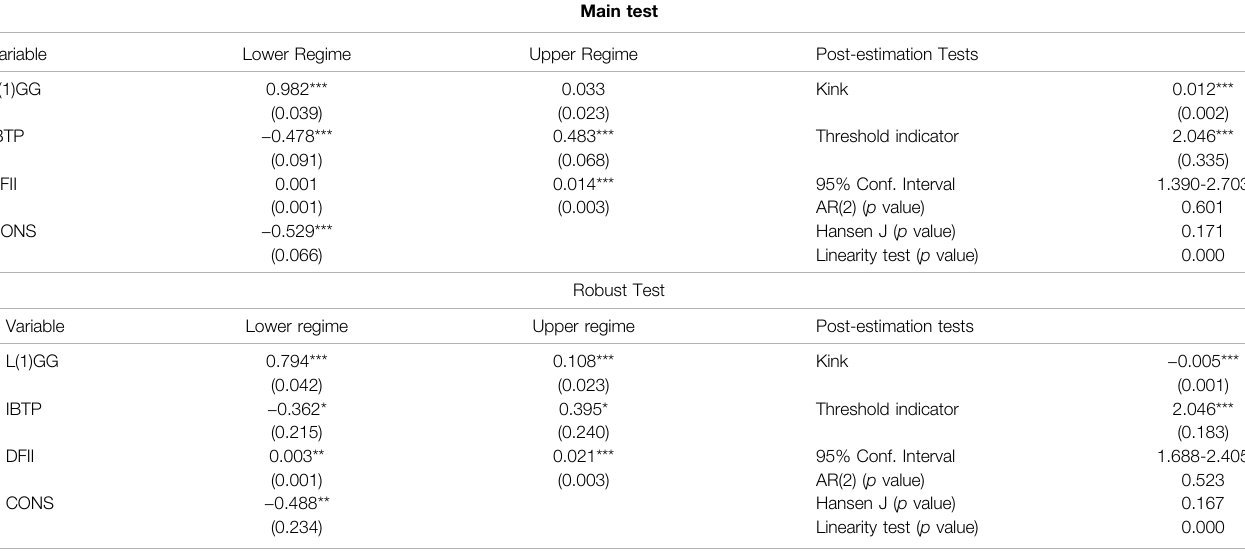
TABLE 6 | Results for the threshold effect of input biased technological progress (IBTP) on green growth